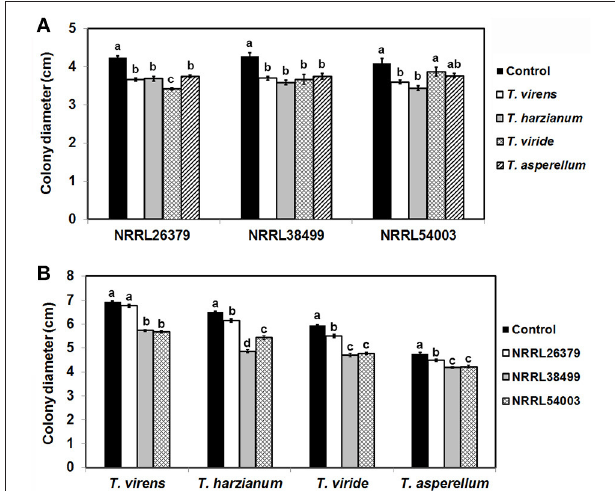
FIGURE 2 | Inhibitory effect of volatile compounds (VCs) produced by Trichoderma and Fusarium oxysporum. After sandwiching culture plates of Trichoderma and F. oxysporum as described in Figure 1A , colony diameters of (A) three F. oxysporum strains after co-cultivation with four Trichoderma spp. and (B) four Trichoderma spp. after co-cultivation with three F. oxysporum strains were measured. Control treatments for (A,B) consisted of F. oxysporum and Trichoderma culture plates, respectively sandwiched with un-inoculated PDA plates. Values shown correspond to the mean standard ± deviation (SD) of data from three replicates. Different letters indicate significant differences based on Fisher’s test at P =